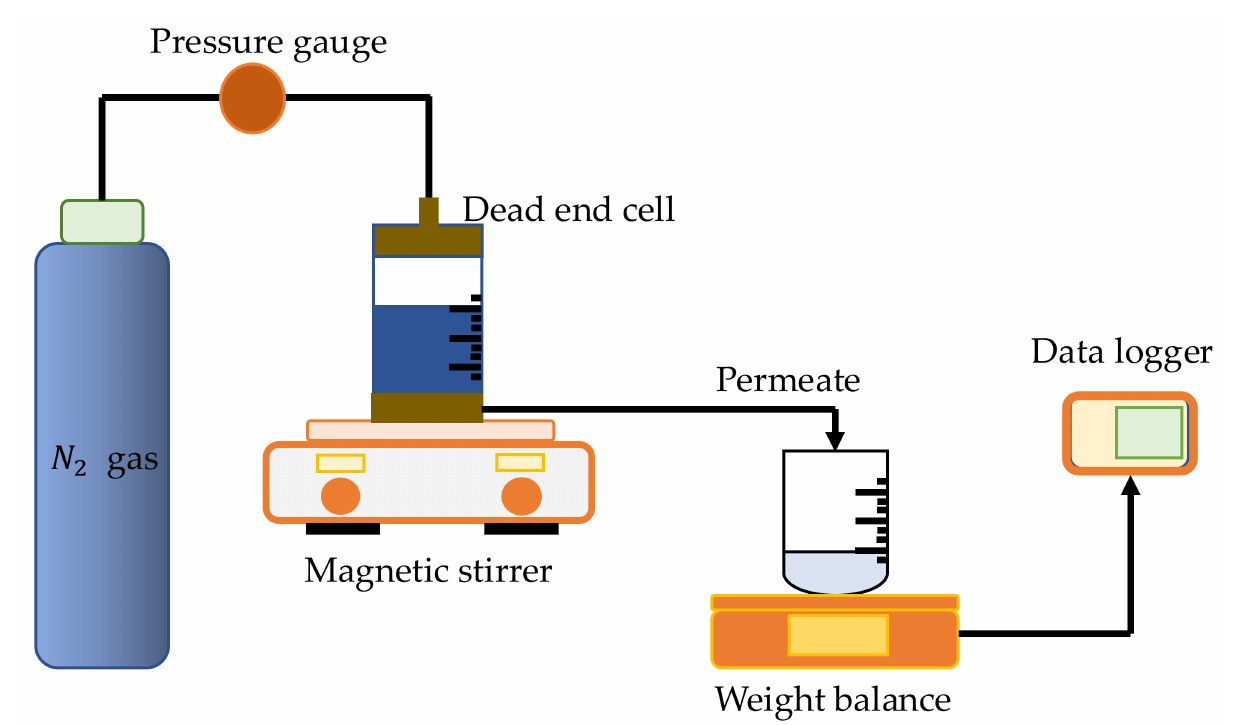
Figure 3. Experimental setup of the water flux